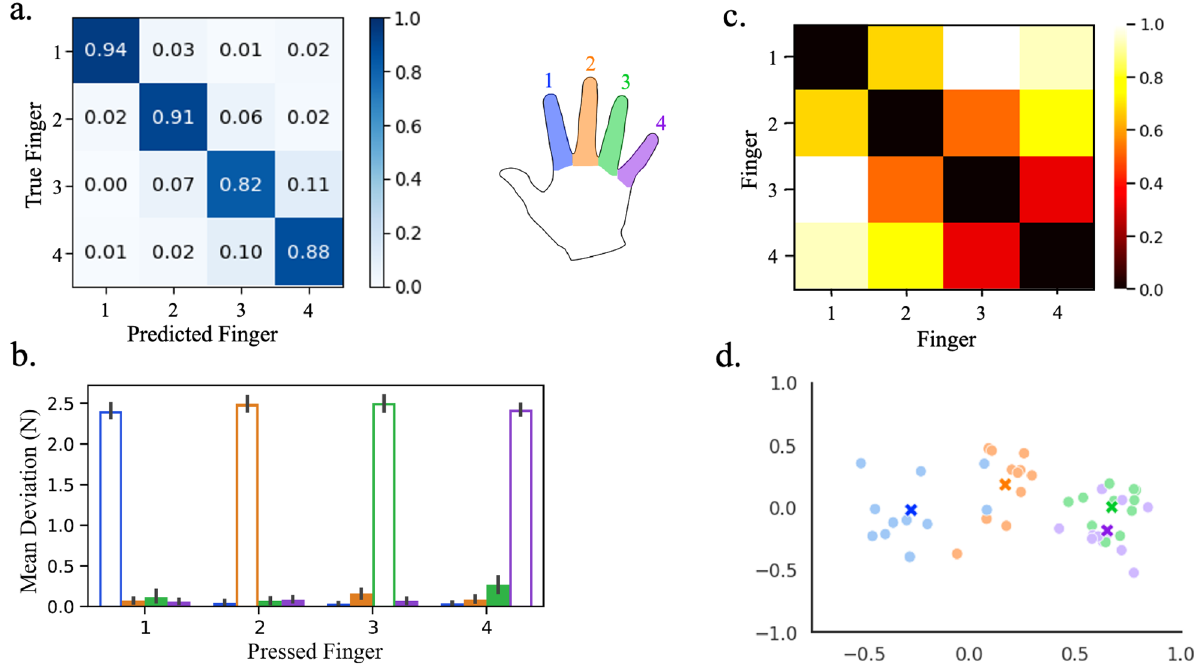
Figure 4. Representational overlap between neighboring digits contribute to increased misclassification of finger presses. ( a ) Confusion matrix of classifier predictions trained on hyperaligned data. ( b ) Mean deviation from baseline force of the uninstructed fingers (filled bars) compared to the mean press force of each instructed finger (hollow bars). Error bars indicate a 95% confidence interval. ( c ) Average representational dissimilarity matrix of neural patterns associated with finger presses. ( d ) Two-dimensional projection of the representation structure using multidimensional scaling. Dissimilarity is reflected by the distance in the 2 dimensions. The mean representation across participants in panel d is shown as an ‘X’. Individual digits are represented by different colors and numbers (see key in center). Data is only shown from the 11 participants from Oblak et al. 35 whose force data was